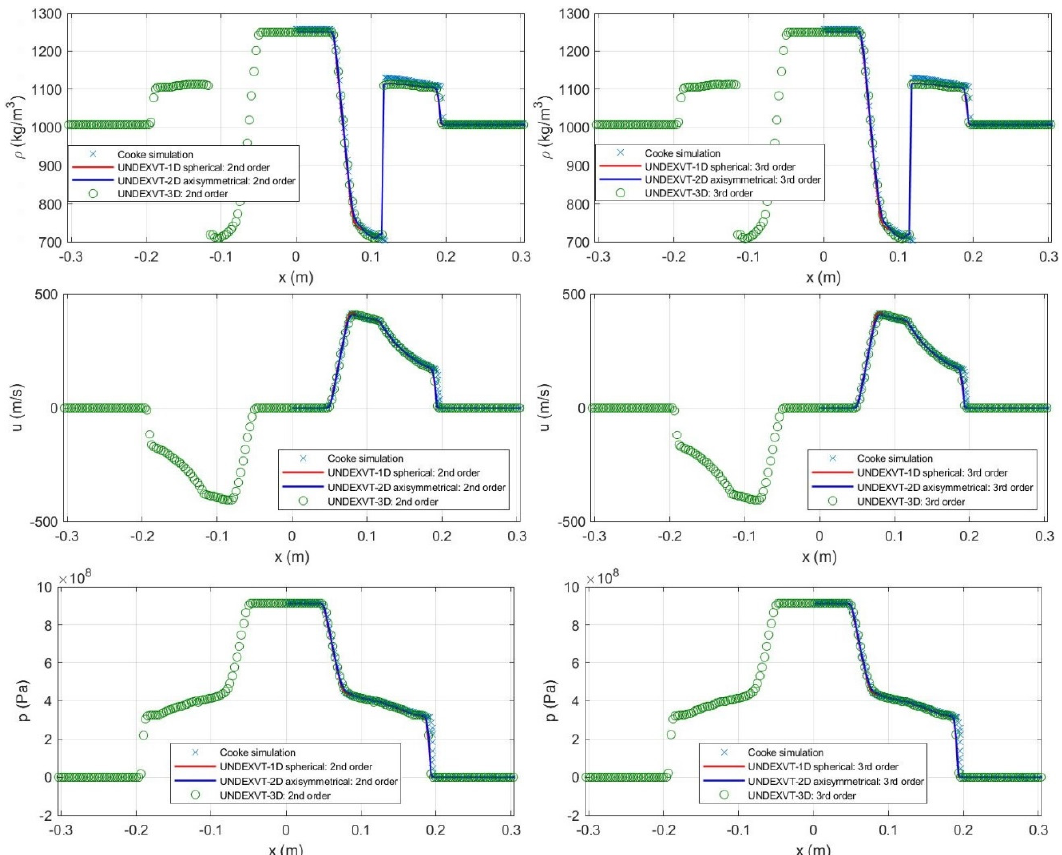
Figure 19. Solution at 4.55 × 10 (cid:2879)(cid:2873) s using a 2D axi-symmetric third-order solver ( top left : density; top right : pressure; bottom : velocities in the x and y directions from left to right ).